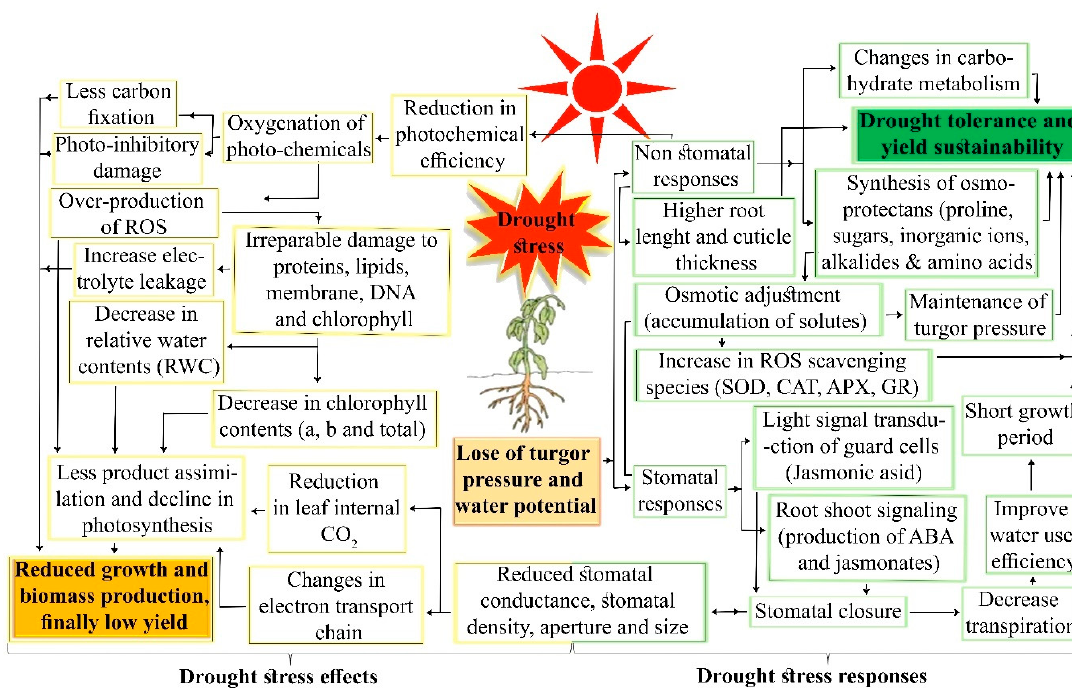
Figure 3. Overall pathways of drought stress effects and plant responses to drought stress.